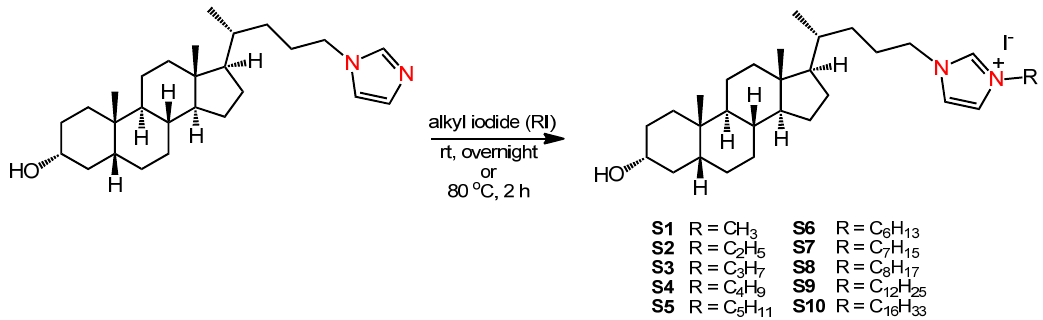
Figure 7. Synthesis of imidazolium salts based on lithocholic acid from N -LCA-substituted imidazole.